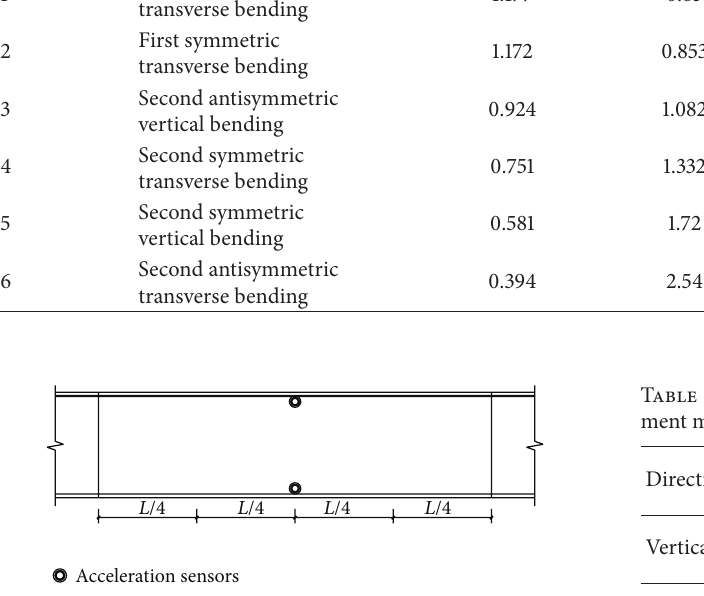
Figure 10: Arrangements of acceleration sensors in the spans of S006-S007 and S007-S008.